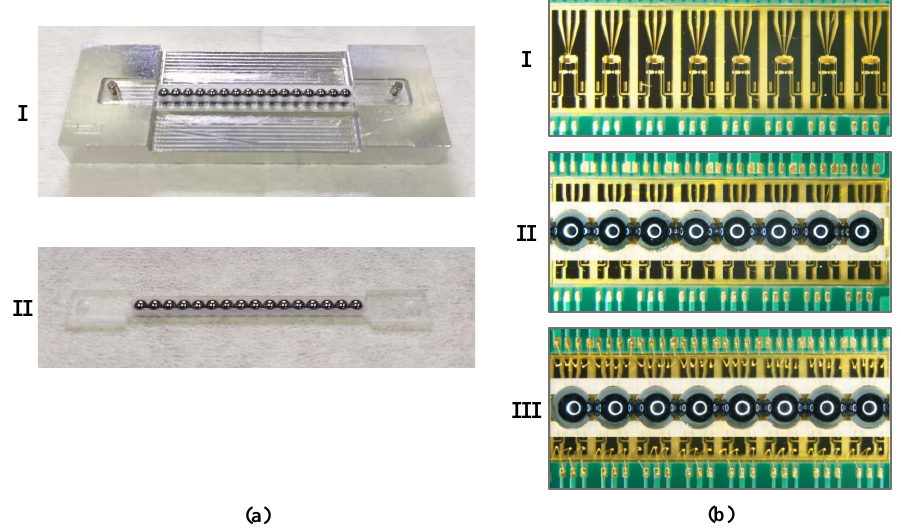
Figure 16. ( a ) Details of the assembly for silicon lens array. ( b ) Details of the assembly for TeraLDAs and silicon lens array (8-pixel of the whole